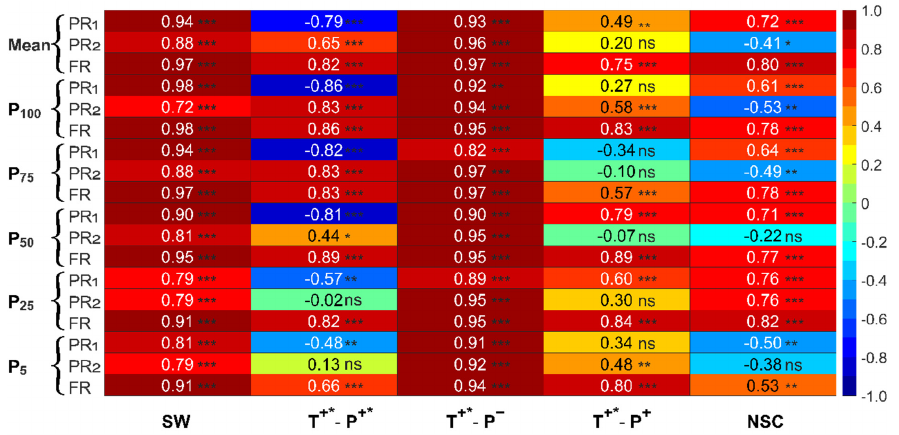
Figure 4. Correlation coefficients between NDVI and temperature and precipitation over 15 years of sliding. PR 1 represent partial correlation between NDVI and temperature; PR 2 represent partial correlation between NDVI and precipitation; FR represent multiple correlations between NDVI and temperature and precipitation. “*”, “**”, and “***” indicate the significance of p < 0.1, p < 0.05, and p < 0.01, respectively.